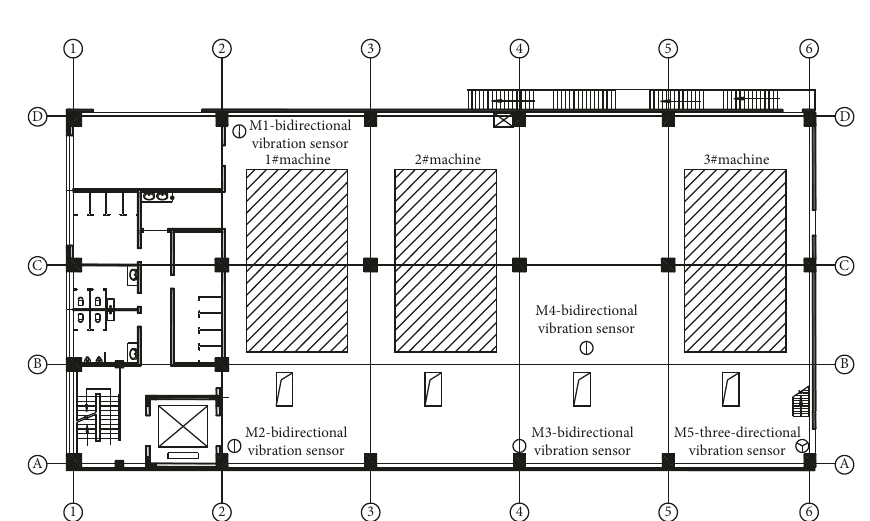
Figure 4: Plane layout of measuring points.